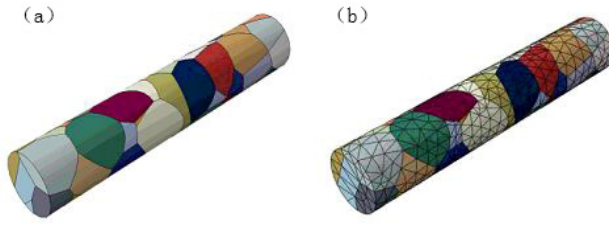
Figure 1. Polycrystalline model: ( a ) before meshing; ( b ) after meshing. This research independently designed thread rolling forming equipment. The power of the equipment comes from the motor, and the movement of the top and bottom dies is completed by the transmission of the drive shaft. The transmission shaft drives the movement of the gears. The gears mesh with each other, and the top and bottom dies are driven by the connecting rod. In this way, the reciprocating movement between top and bottom dies can be realized. Combined with the pressure applied to the top die, the workpiece is deformed in this process, and the thread rolling process is formed. Figure 2b is a simplified thread rolling finite element model. As shown in Figure 2d, the length of the workpiece changes from 10 mm to 21 mm and the diameter changes from 3 mm to 2 mm after the thread rolling experiment. The thread rolling model is shown in Figure 2.